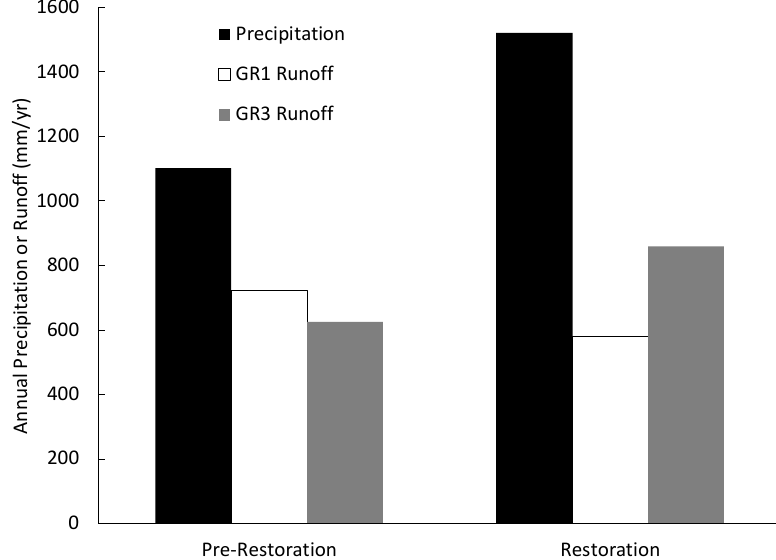
Figure 5. Annual precipitation and runoff/streamflow for the pre- and during-restoration phases of the project for upstream (GR1) and downstream (GR3) sites.